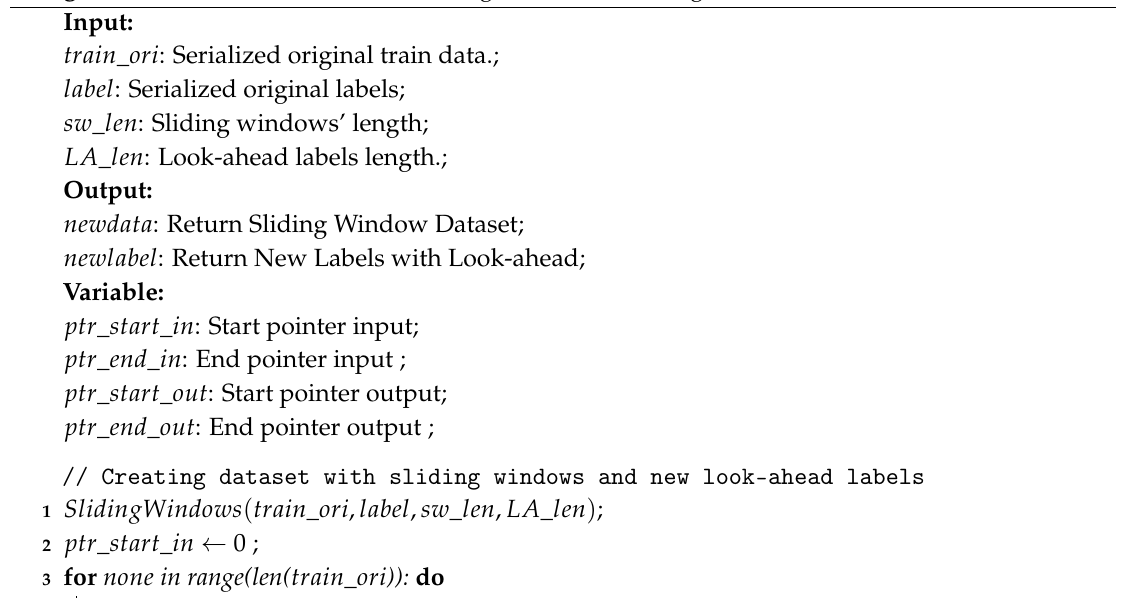
Algorithm 5 To_Serialization: Generating Labels and Sliding